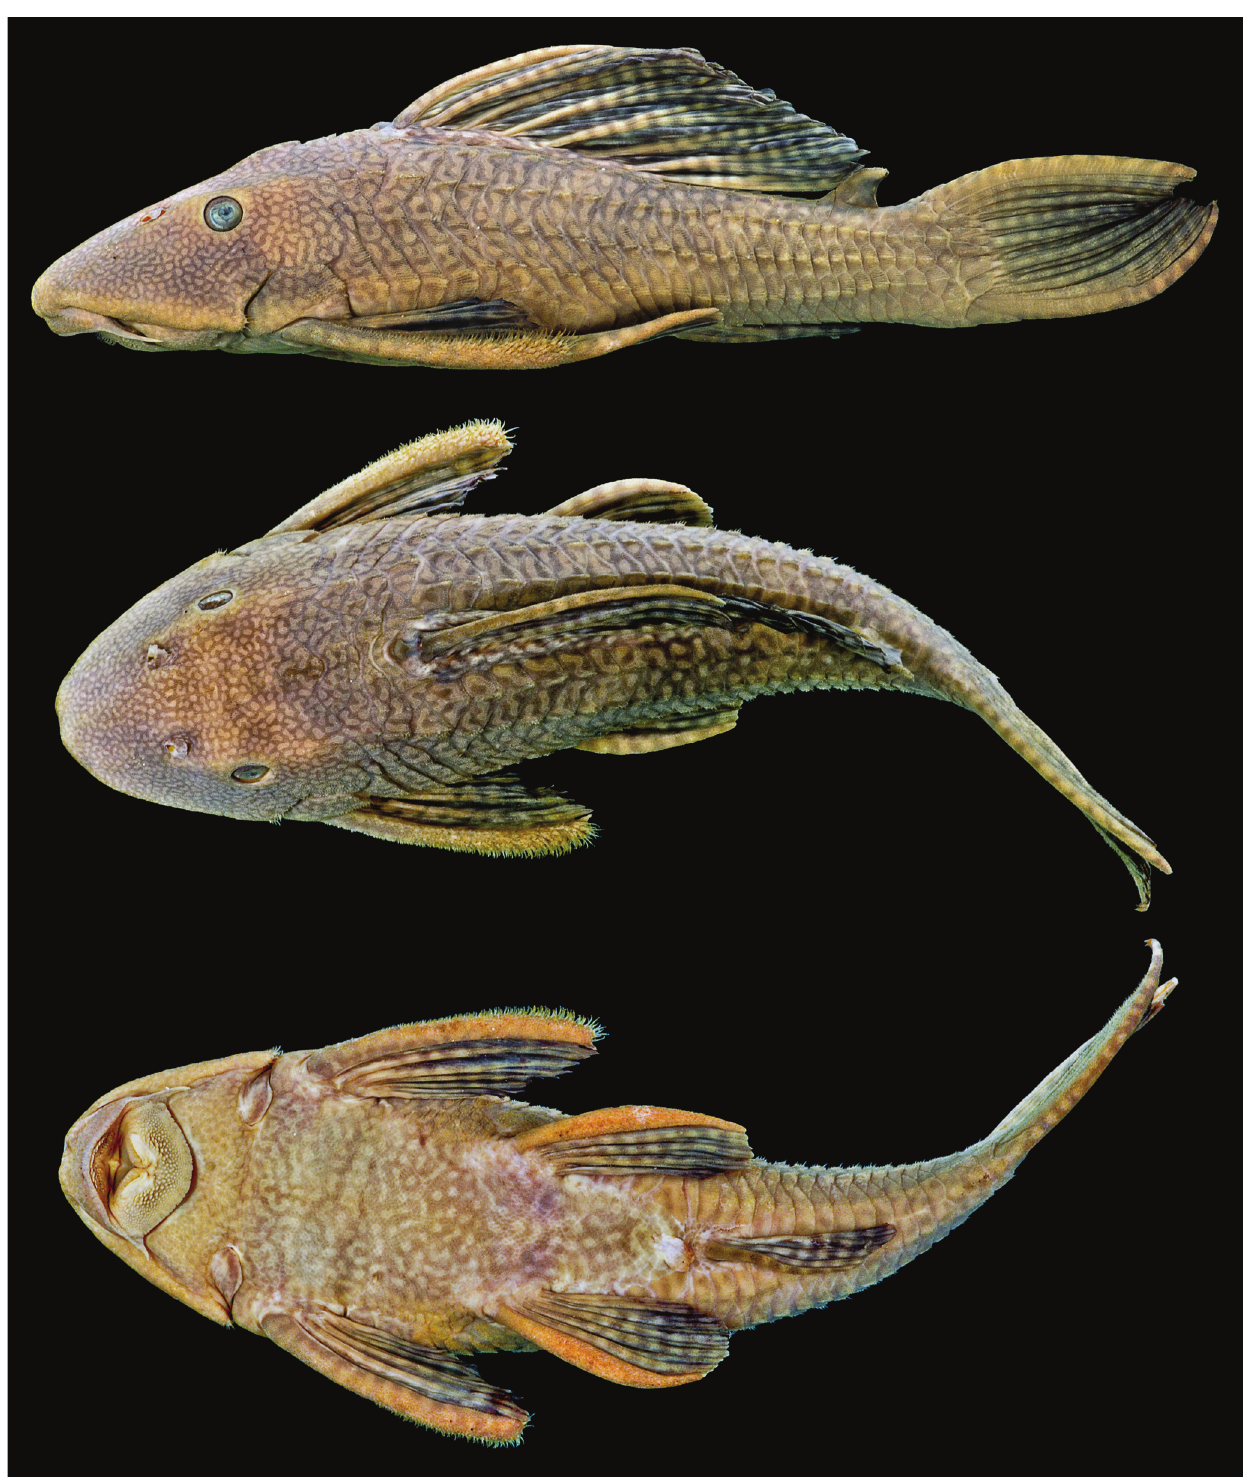
Fig. 1. Hypostomus delimai new species, INPA 6191, holotype, 235.2 mm SL, in lateral, dorsal, and ventral views,